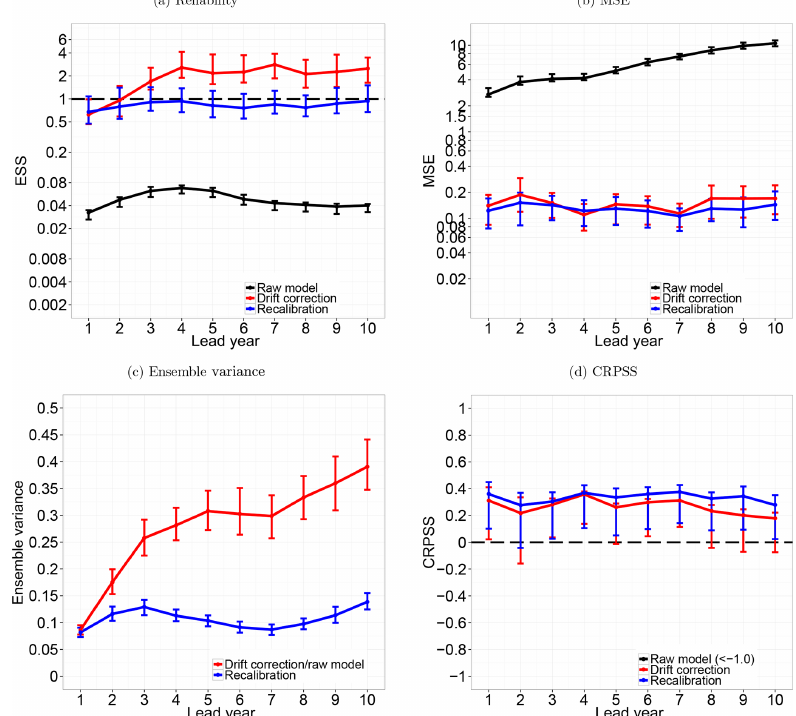
Figure 6. Reliability (a) , MSE (b) , ensemble variance (c) and CRPSS (d) of surface temperature over the North Atlantic without any correction (black line), after drift correction (red line) and recalibration with DeFoReSt (blue line). The CRPSS for the raw forecasts (black line) is smaller than − 1 and therefore not shown. As the drift correction method does not account for the ensemble spread, the ensemble variance of the raw model and the drift-corrected forecast is equal. The vertical bars show the 95% confidence interval due to 1000-wise